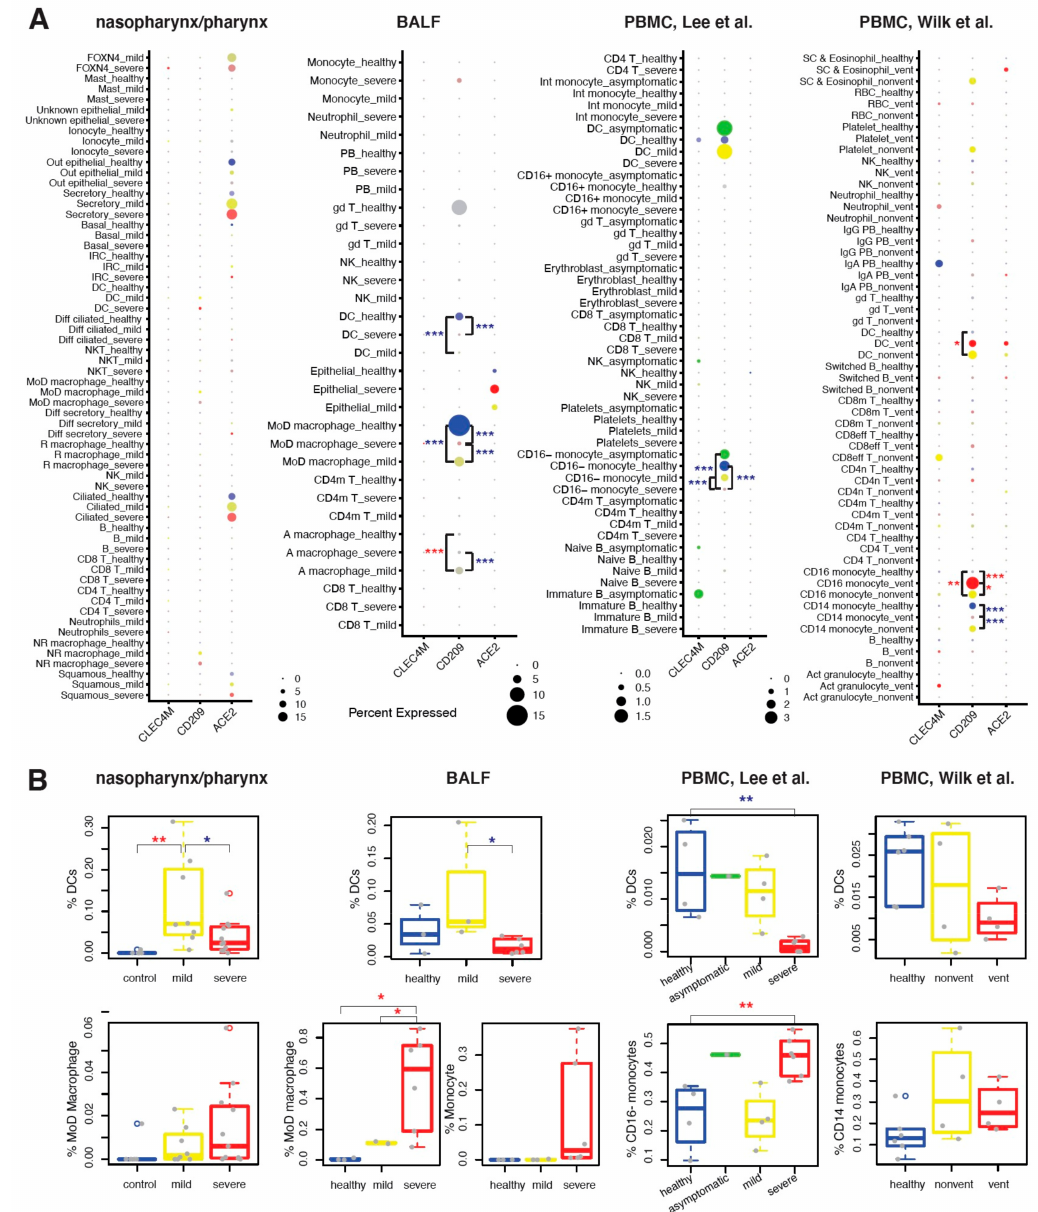
Figure 3. Gene expression differences of three SARS-Cov-2 receptors in upper airway, lung and blood of healthy and COVID- 19 cases. ( A ) Variations of expression profiles of ACE2 , CD209 and CLEC4M in cell types identified from four scRNA-seq datasets of nasopharynx/pharynx, BALF and PBMC samples from COVID-19 patients and healthy controls. For each dataset, the detection rate and the average expression level of each receptor in identified cell types are illustrated. The detection rate was showed by dot size and a larger size indicates a higher detection rate. The average expression level is showed by the color scale of dot, from grey to blue (for healthy control), green (for asymptomatic cases), yellow (for mild cases) and red (for severe cases). A darker color indicates a higher expression level. The gd T cell in healthy BALF samples was shown in grey because only a limited number of cells was detected ( n = 20). ( B ) Variations of the proportions of DCs, macrophages or monocytes in WBC in samples from COVID-19 patients and healthy controls. For each group of disease status, cell proportions were shown in boxes and data from a particular participant was shown by a dot. In DCs, monocytes and monocytes, differences in ( A ) gene expression and ( B ) cell proportions were tested in severe cases compared to mild cases, in severe cases compared to healthy controls, in mild cases compared to healthy controls, in severe cases compared to asymptomatic cases, in mild cases compared to asymptomatic cases, and in asymptomatic cases compared to healthy controls. Significance was shown by red * for higher mean value and blue * for lower mean value, with * p < 0.05; ** p < 0.01; *** p <